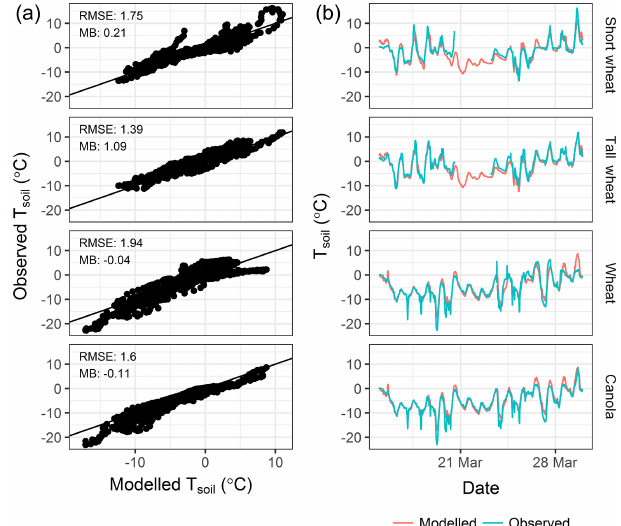
Figure A1. Soil surface temperature observed versus modelled as scatter plots (a) and time series (b)